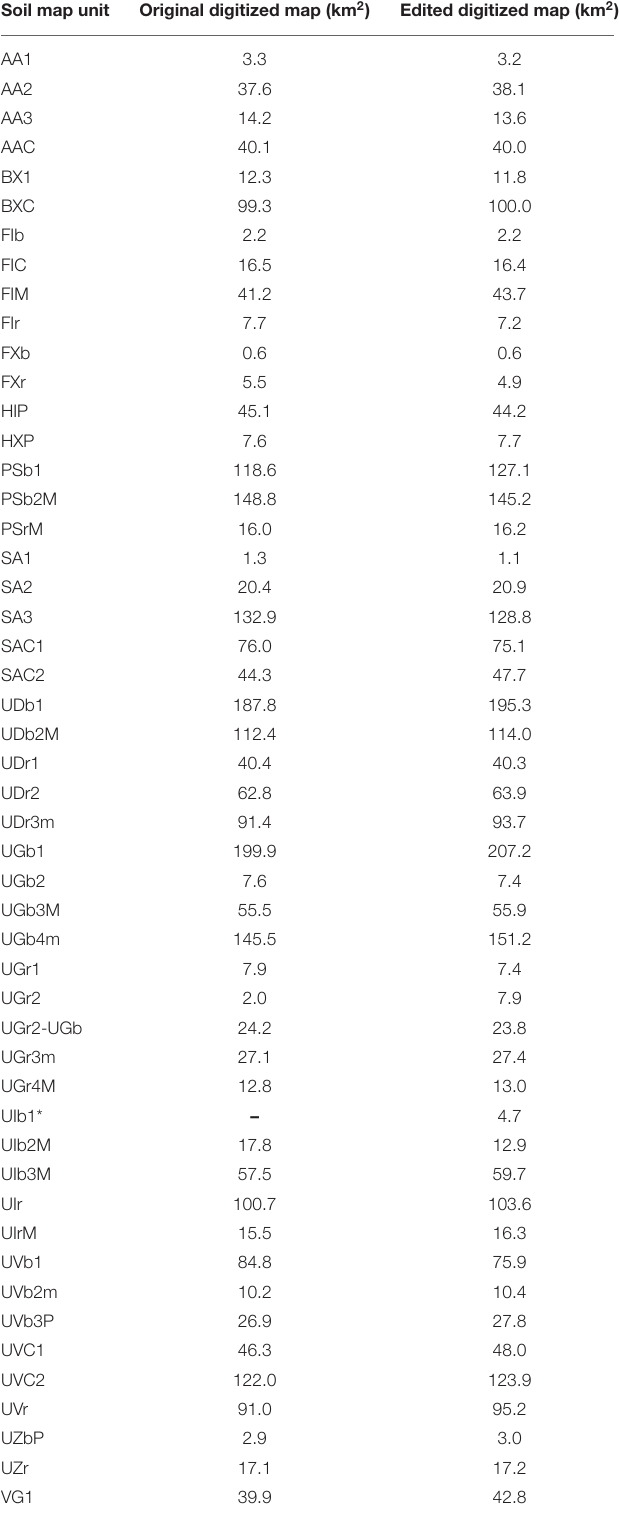
TABLE 3 | Differences in soil map unit acreage between the original and the edited digitized soil map of the Busia Area. Soil map